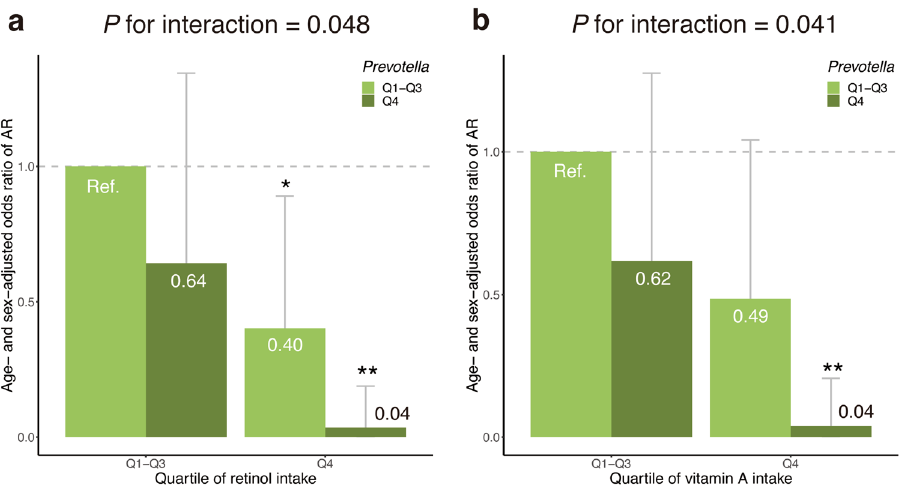
Figure 3. Significant statistical interactions between nutritional and gut microbial variables. Statistical interactions between ( a ) retinol and Prevotella and ( b ) vitamin A and Prevotella are shown. The y -axis indicates the age- and sex-adjusted odds ratio of allergic rhinitis. Error bars indicate 95% confidence interval. ‘*’ indicates P < 0.05; and ‘**’, P < 0.01. AR, allergic rhinitis; Q, quartile; Ref., reference